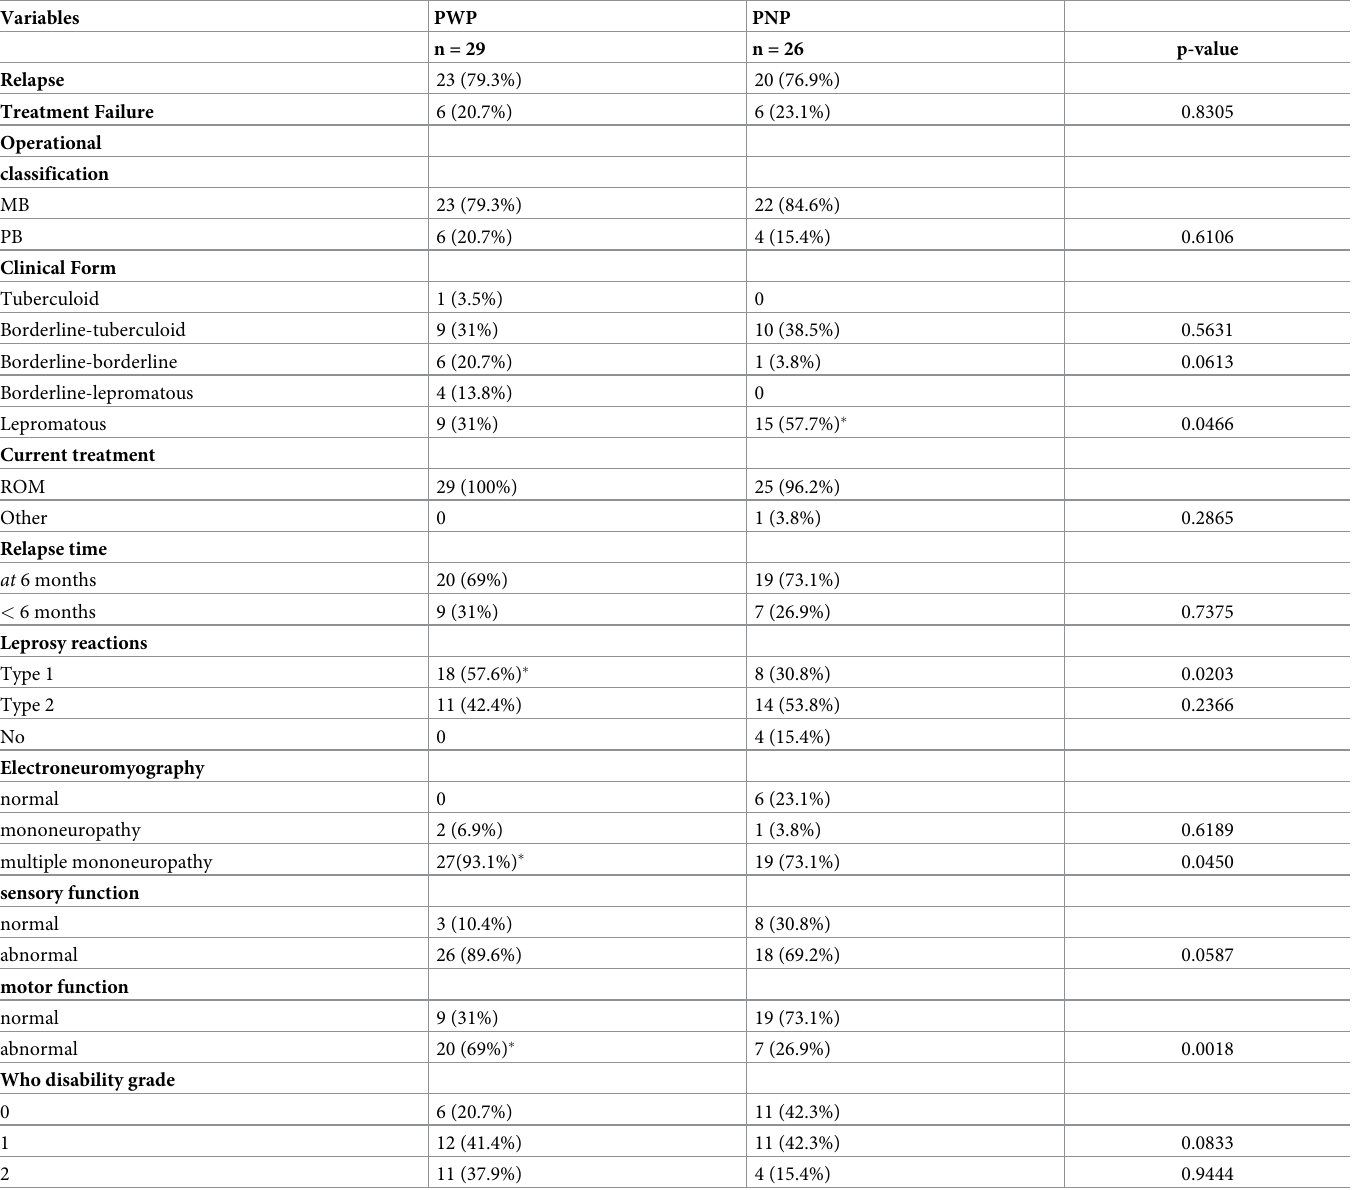
Table 1. Clinical characteristics of the patients with and without neuropathic